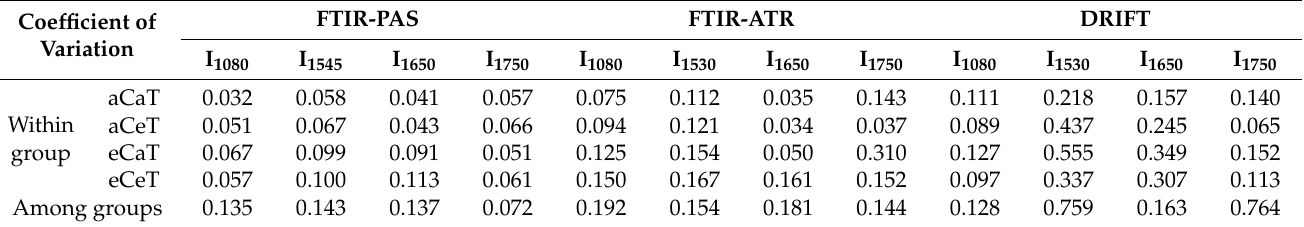
Table 2. CV of spectral intensity within group and between groups.